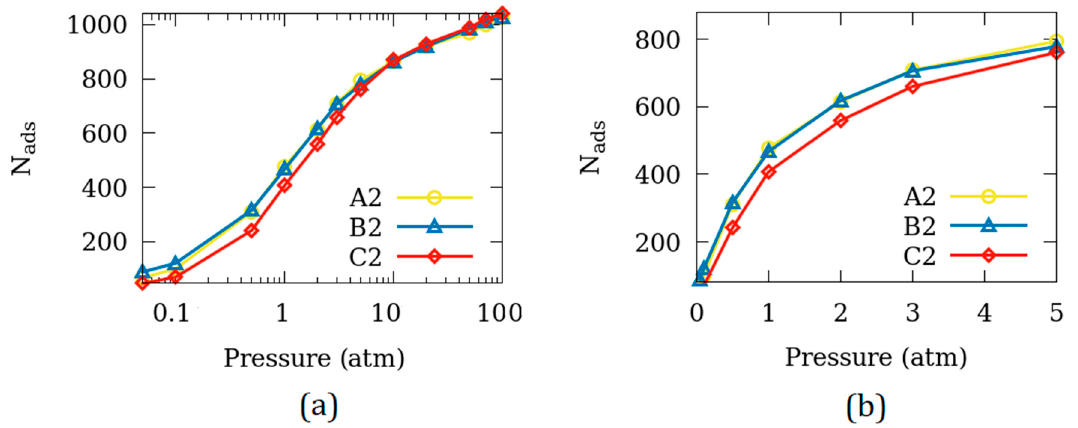
Figure 5. Effect of the surface exposed on the adsorbed amount over ( a ) full range of partial pressures and ( b ) the range of partial pressures relevant for applications. Only C2 sample shows a slight under ‐ adsorption, probably due to the difference in the dimensions of the three surfaces. The uncertainty in N ads is smaller than the symbols.